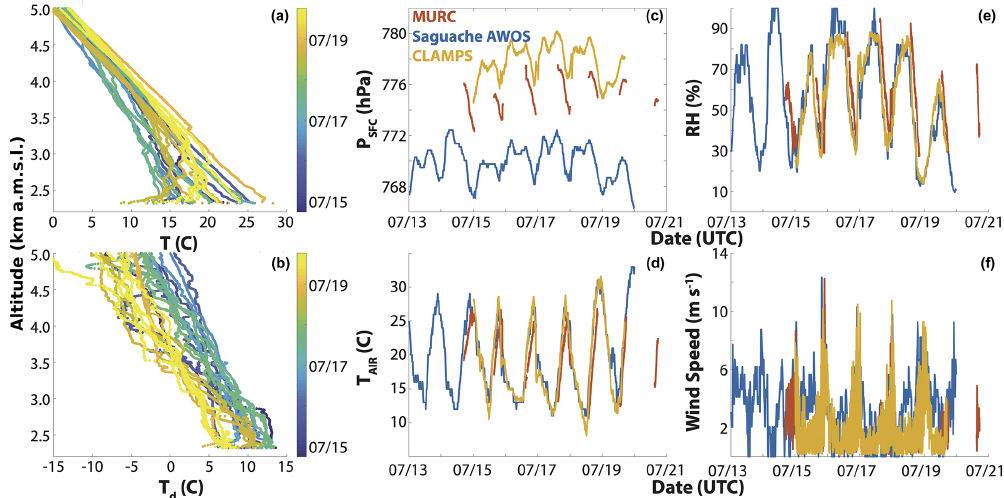
Figure 2. An overview of meteorological conditions observed in the San Luis Valley during LAPSE-RATE. The two leftmost figures illustrate temperature (a) and dew point (b) profiles obtained from radiosondes launched at Leach Airport, with the colors representing the date of launch. The center and righthand panels illustrate surface meteorology at three different sites across the valley over the course of the week. These include surface pressure (c) , air temperature (d) , relative humidity (e) , and wind speed (f) . These observations were obtained by the MURC vehicle (red), the Saguache Airport AWOS station (blue), and the CLAMPS trailer